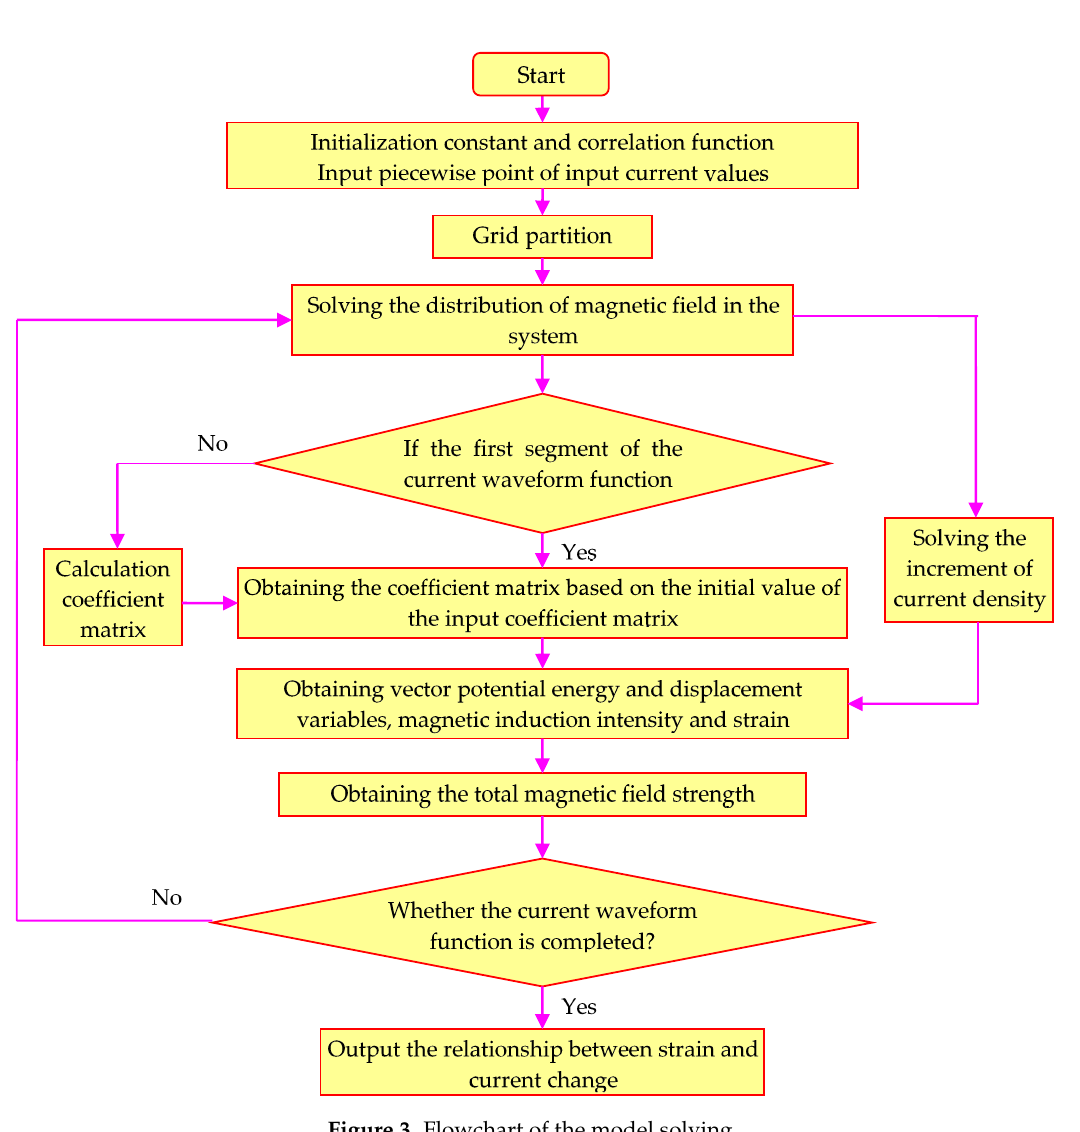
Figure 3. Flowchart of the model solving.